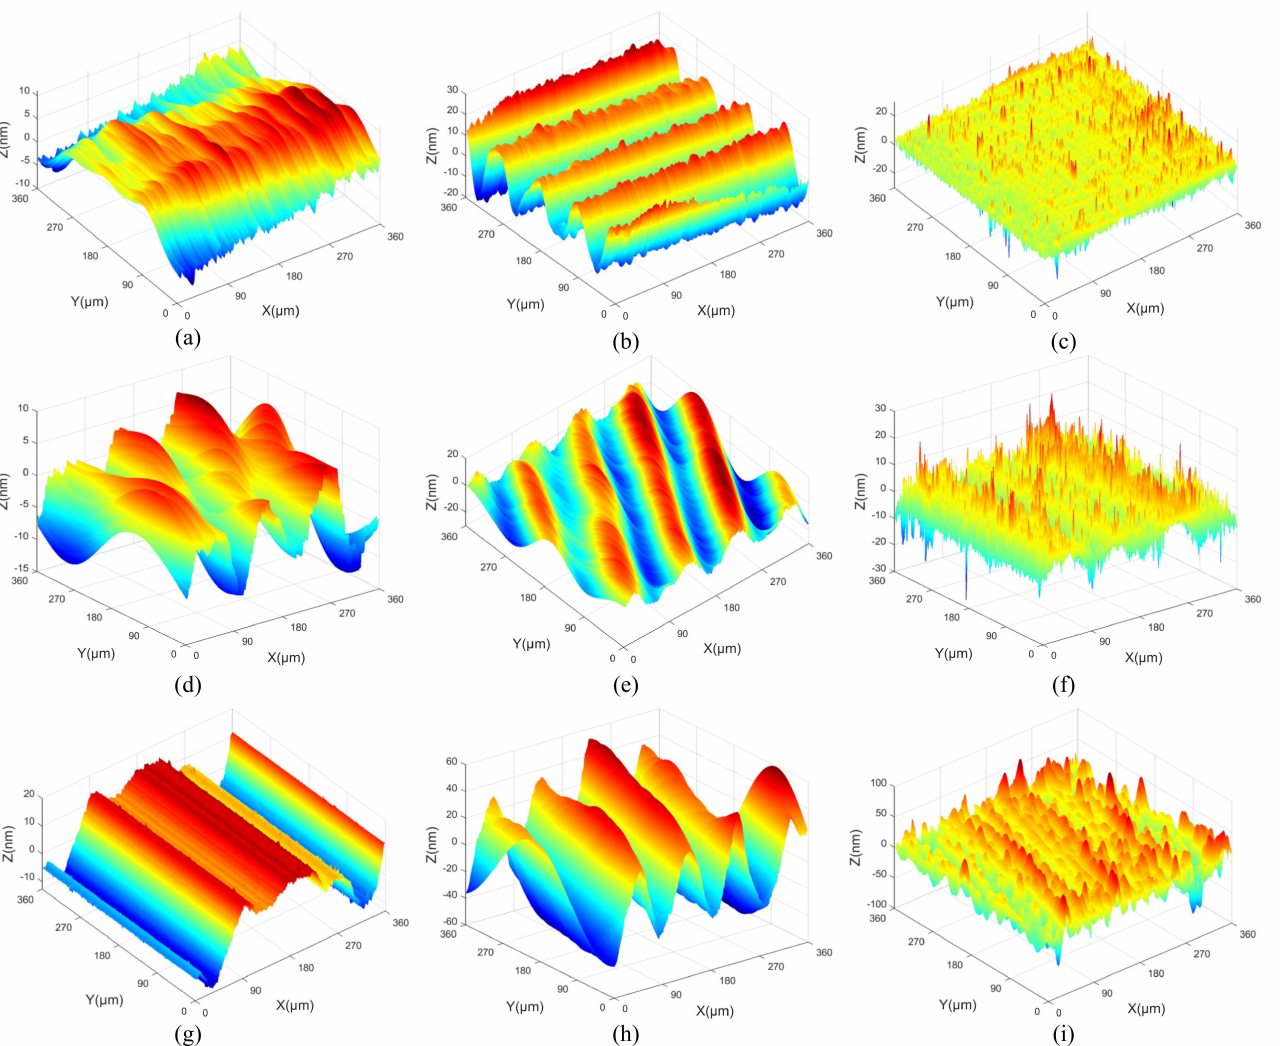
Figure 9. The reconstruction results of spatial frequency features with different spindle speeds: ( a ) low-frequency of n = 1300 r/min, ( b ) middle-frequency of n = 1300 r/min, ( c ) high-frequency of n = 1300 r/min, ( d ) low-frequency of n = 1400 r/min, ( e ) middle-frequency of n = 1400 r/min, ( f ) high-frequency of n = 1400 r/min, ( g ) low-frequency of n = 1500 r/min, ( h ) middle-frequency of n = 1500 r/min, ( i ) high-frequency of n = 1500